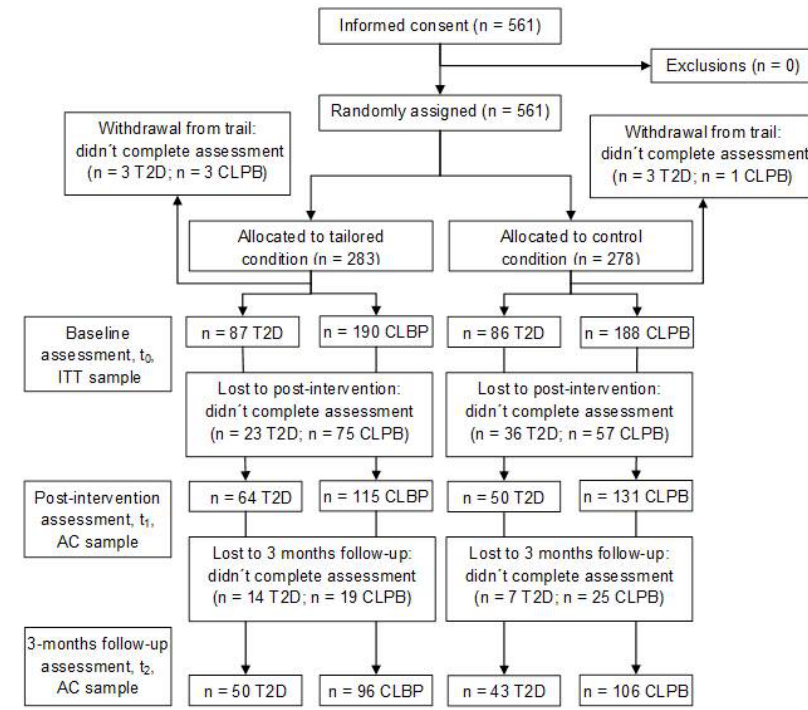
Figure 3. Flow of participants after randomization (ITT=intention-to-treat, AC=available